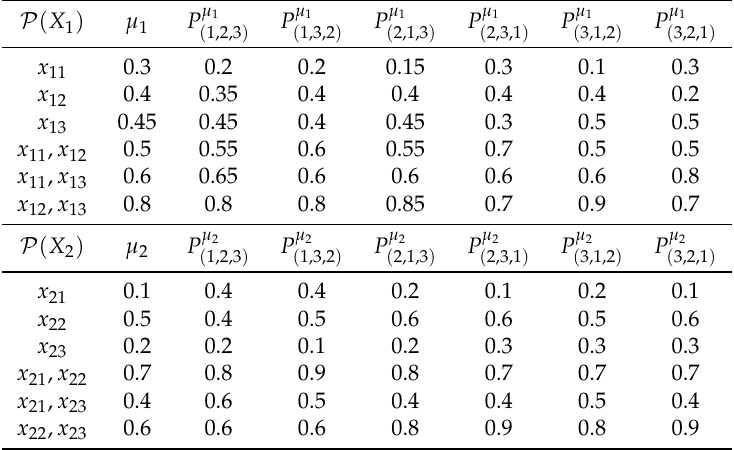
Table 1. Probability measures generated by two sample fuzzy